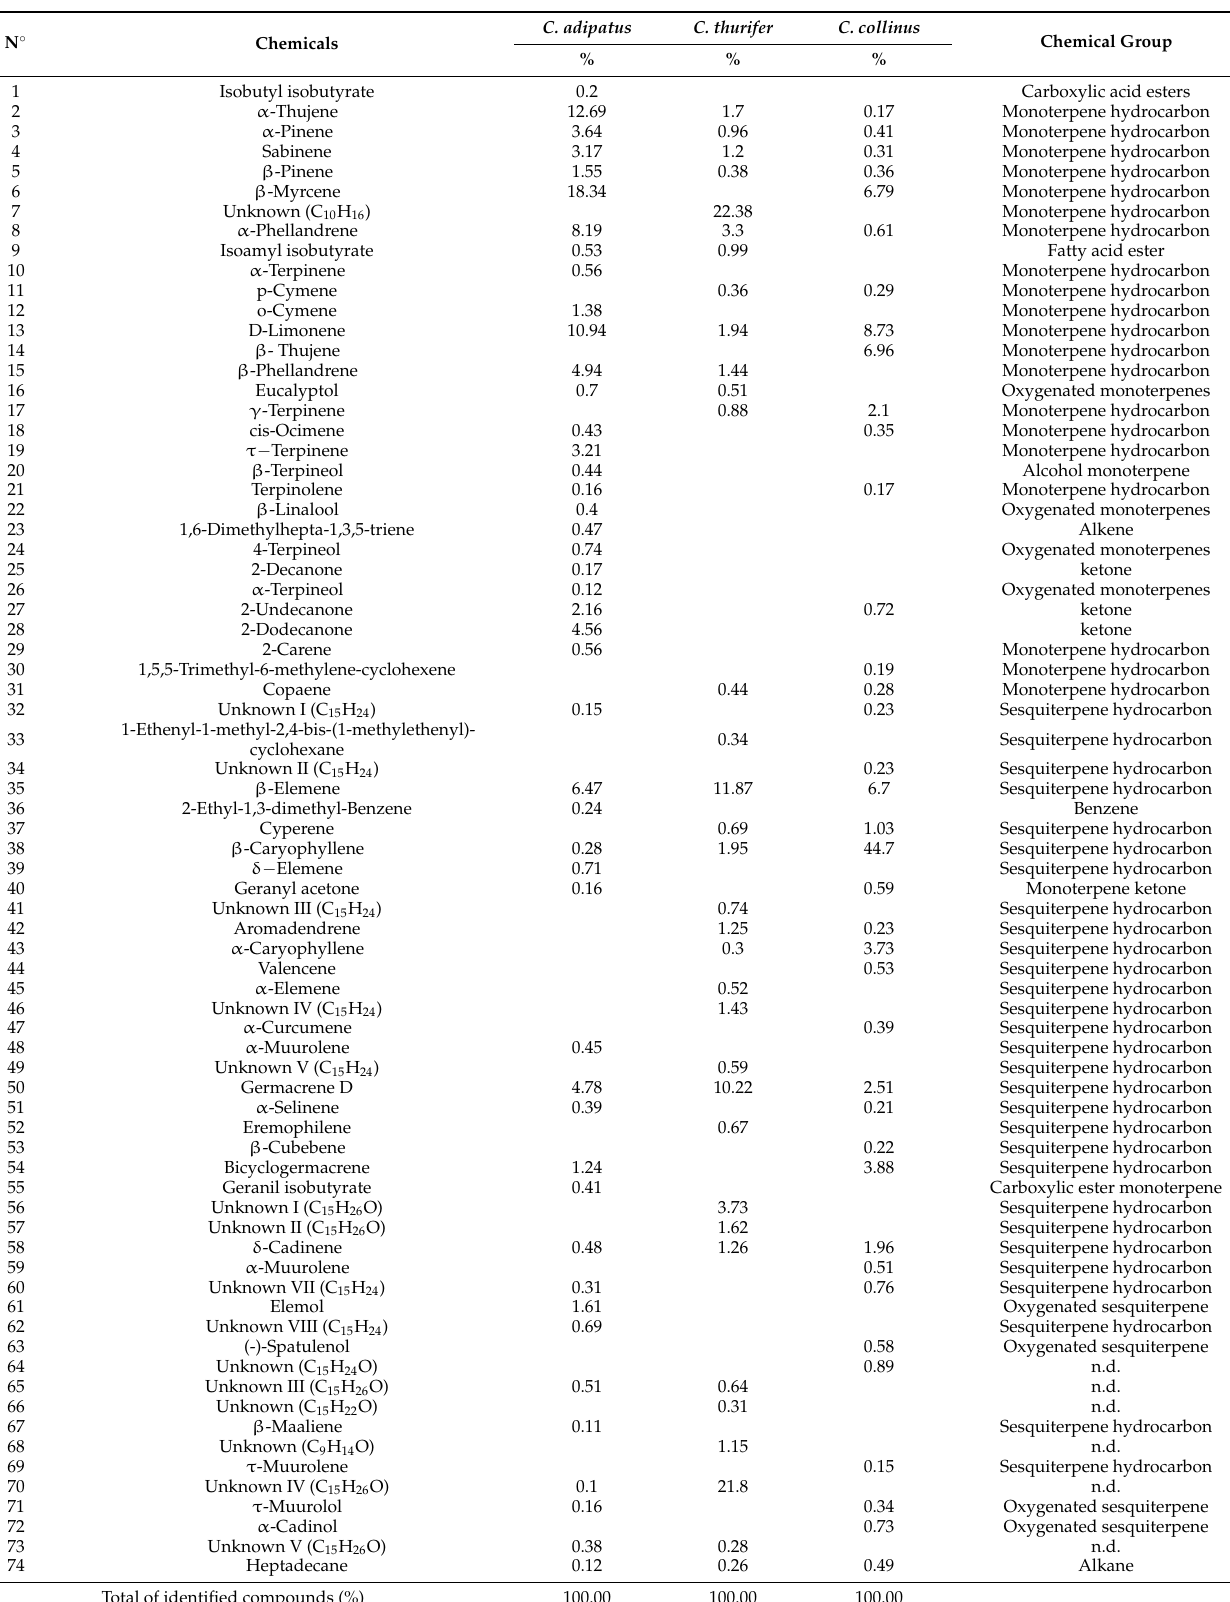
Table 1. Chemical composition of C. adipatus, C. thurifer , and C. collinus essential